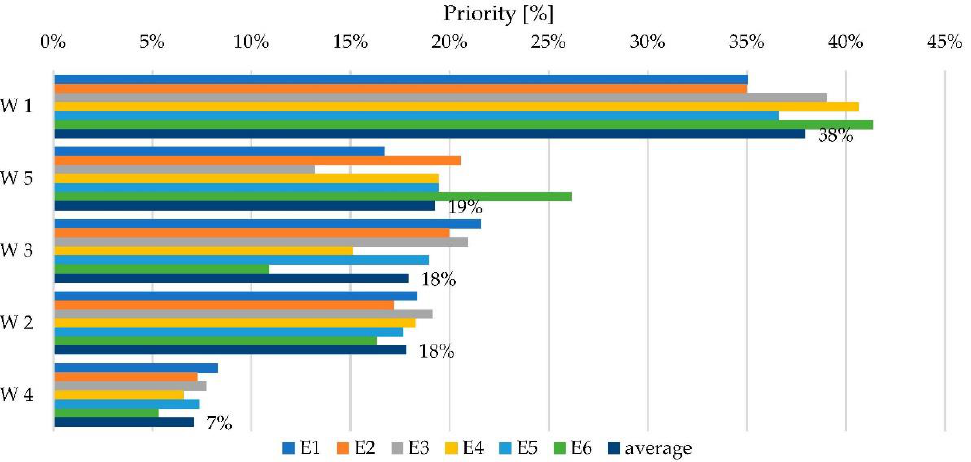
Table 9. Final ranked list of decision variants based on expert scoring.